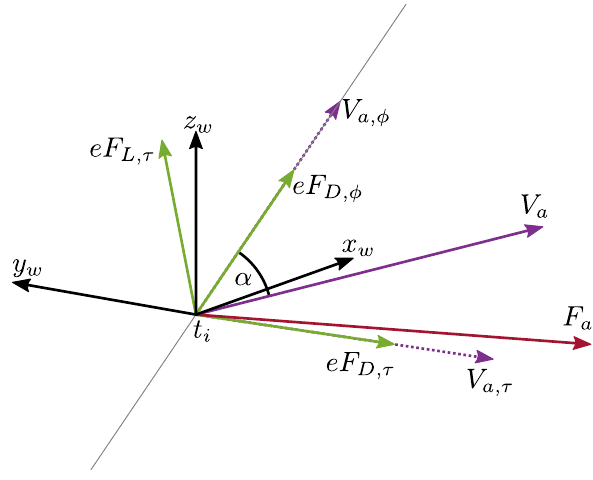
Figure 7. Diagram showing the aerodynamic force on a tether